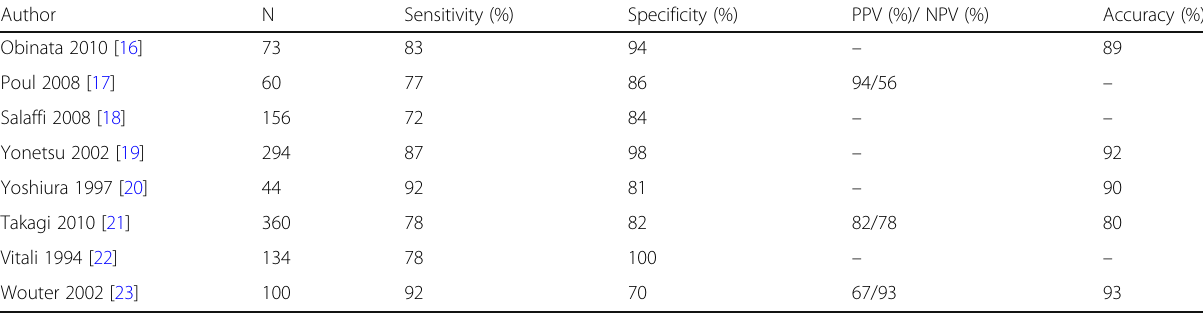
Table 2 Sialography for the diagnosis of Sjögren ’ s syndrome